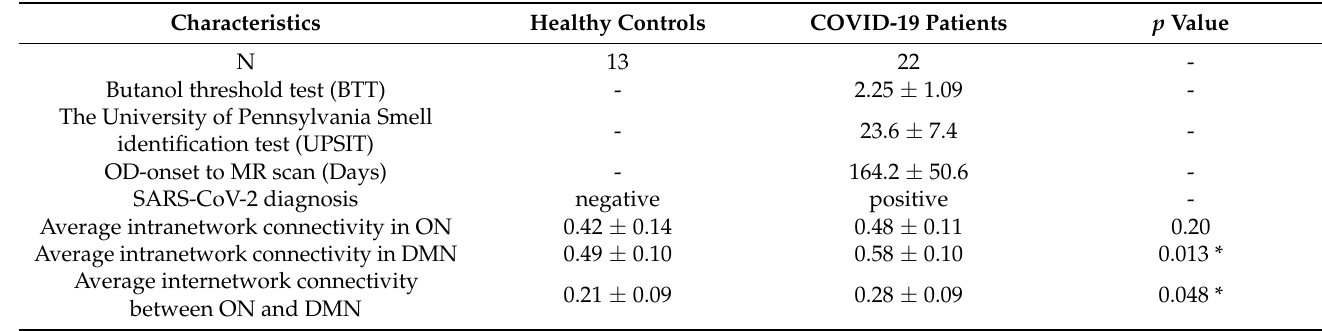
Table 1. Demographic information of this study.